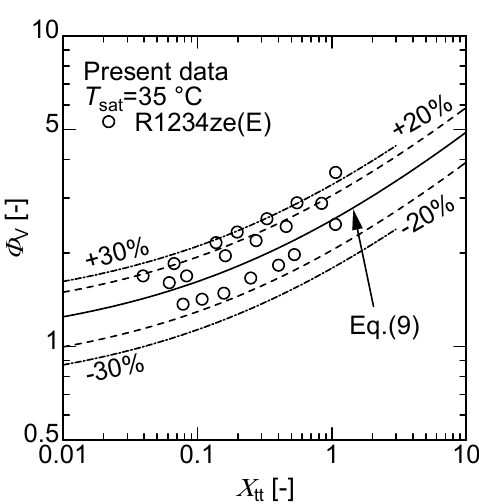
Figure 4. Comparison of pressure drop between that predicted by Hirose et al. correlation and R1234ze(E).